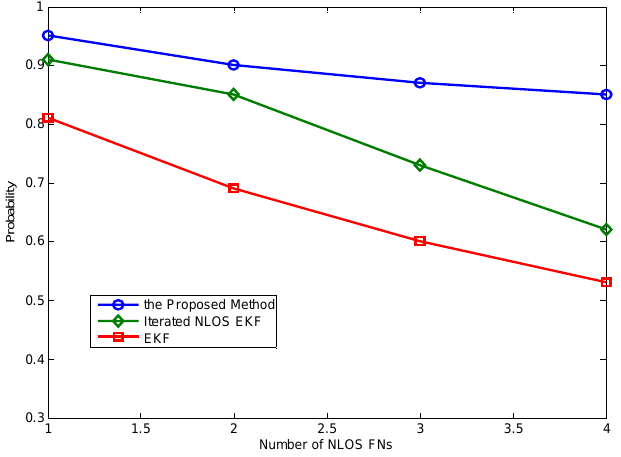
Figure 6. Impact of the number of NLOS FNs on the location accuracy in the good node